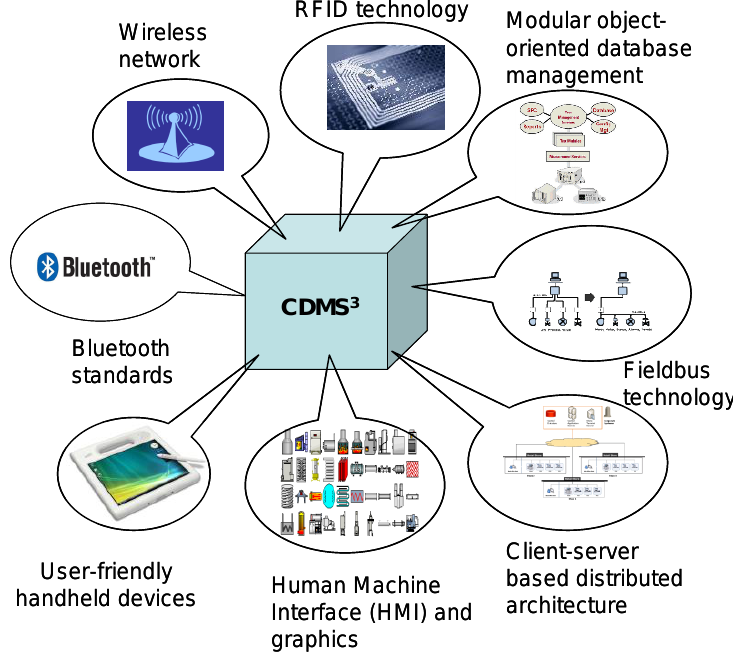
Figure 4. Components of a modern enterprise-wide food processing